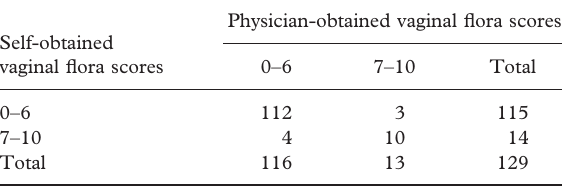
Table I. *Comparison of Gram-stained vaginal fluid collected by the two techniques using dichotomous coding of vaginal flora score.